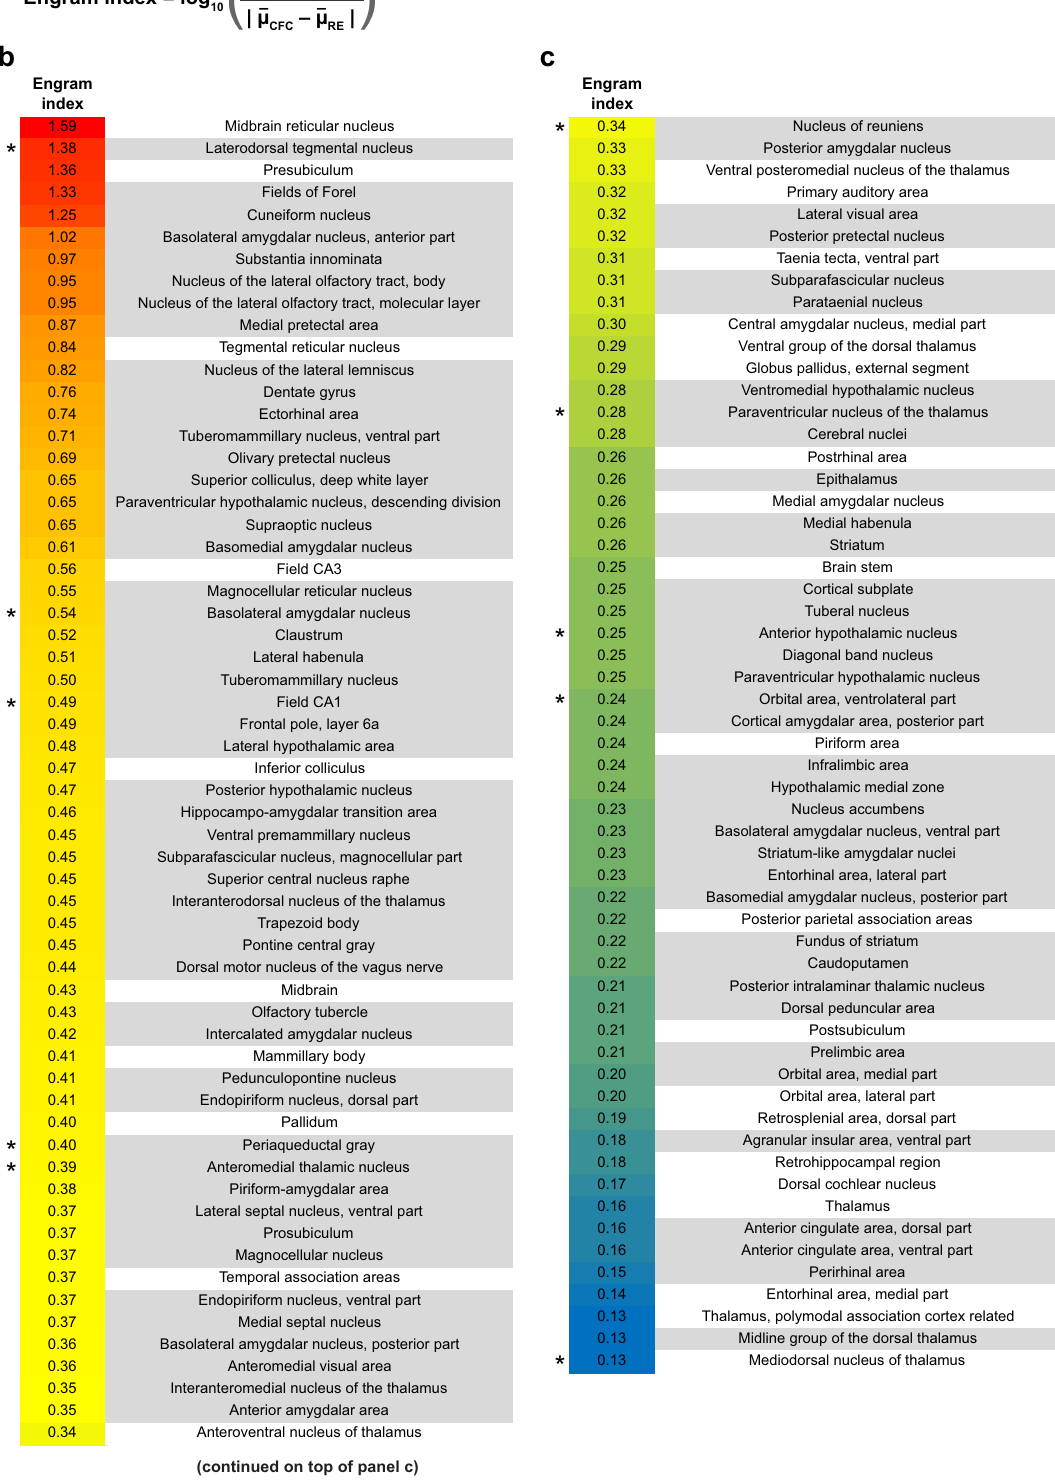
Fig. 2 Brain-wide engram indices. a Engram index equation. Home cage (HC), CFC, and Recall (RE) groups. b , c Rank-ordered list of 117 brain regions with engram indices that passed our statistical criteria (Supplementary Table 1) ( n = 7 home cage mice, n = 10 CFC mice, n = 9 Recall mice). For a list of 130 non-signi fi cant brain regions based on our statistical criteria, refer to Supplementary Table 2. Regions highlighted in gray have also been identi fi ed as exhibiting signi fi cant engram reactivation in Fig. 3. Regions with an asterisk were tested in the optogenetic engram reactivation behavioral experiments described in Fig.